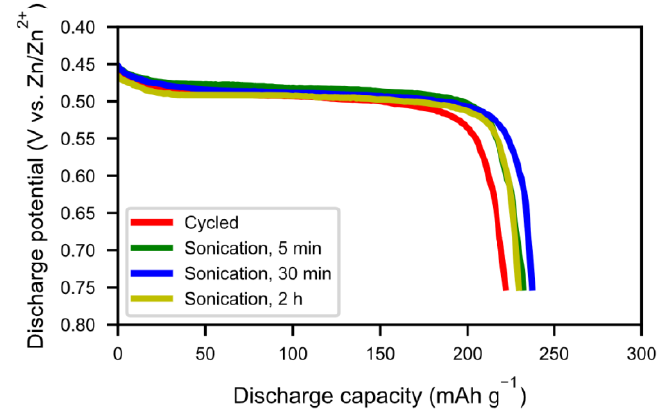
Figure3. Thedischargecurvesat60mAg − 1 forthealloywith5min,30min,and2hofsonotrode-sonication, Figure 3. The discharge curves at 60 mA g −1 for the alloy with 5 min, 30 min, and 2 h of sonotrode- as described in Figures 1 and 2. sonication, as described in Figures 1 and 2.